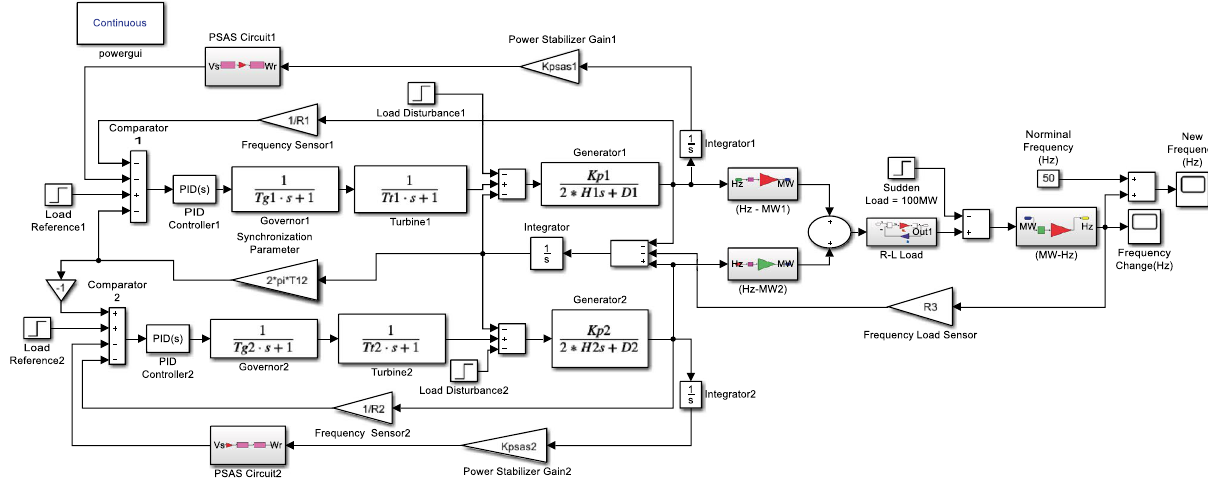
Fig. 9 Proposed two area generations PID PSAS control